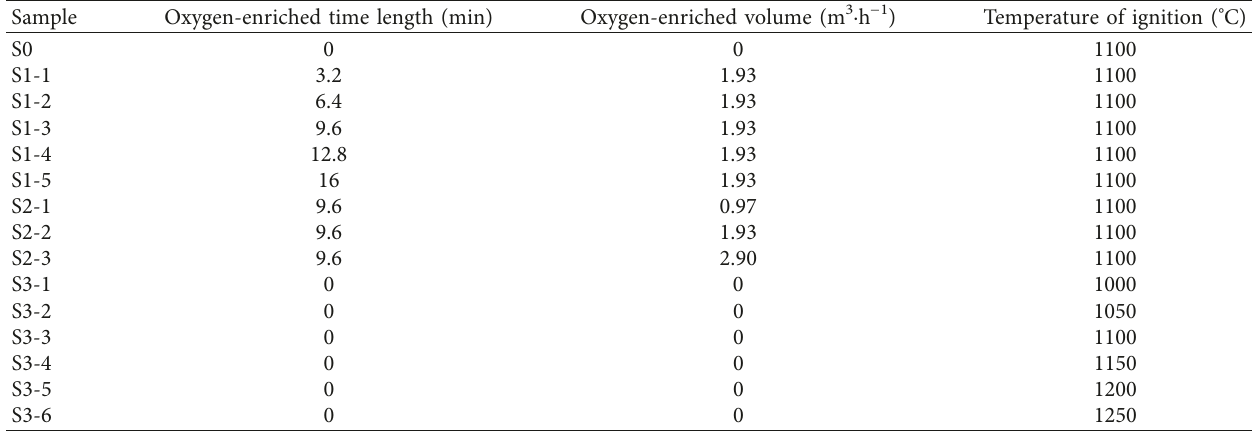
Table 4: Experimental scheme.